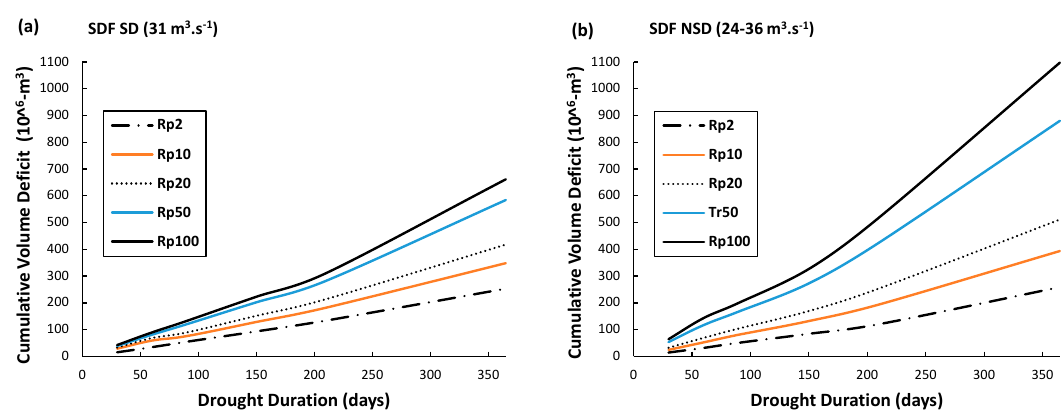
Figure 3. Severity–duration–frequency (SDF) curves under SD and NSD demand assumptions in reconstructed discharge scenarios for 1930–2016: ( a ) SD = 31 m 3 · s − 1 ; ( b ) NSD = 24–36 m 3 · s − 1 .